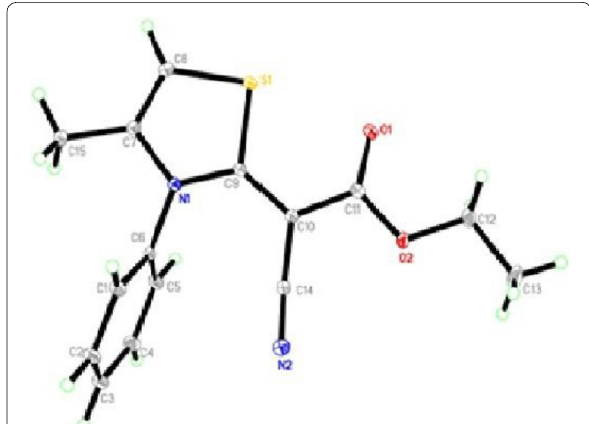
Fig. 1 ORTEP diagram of the thiazole 6 . Displacement ellipsoids are plotted at the 40% probability level for non‑H